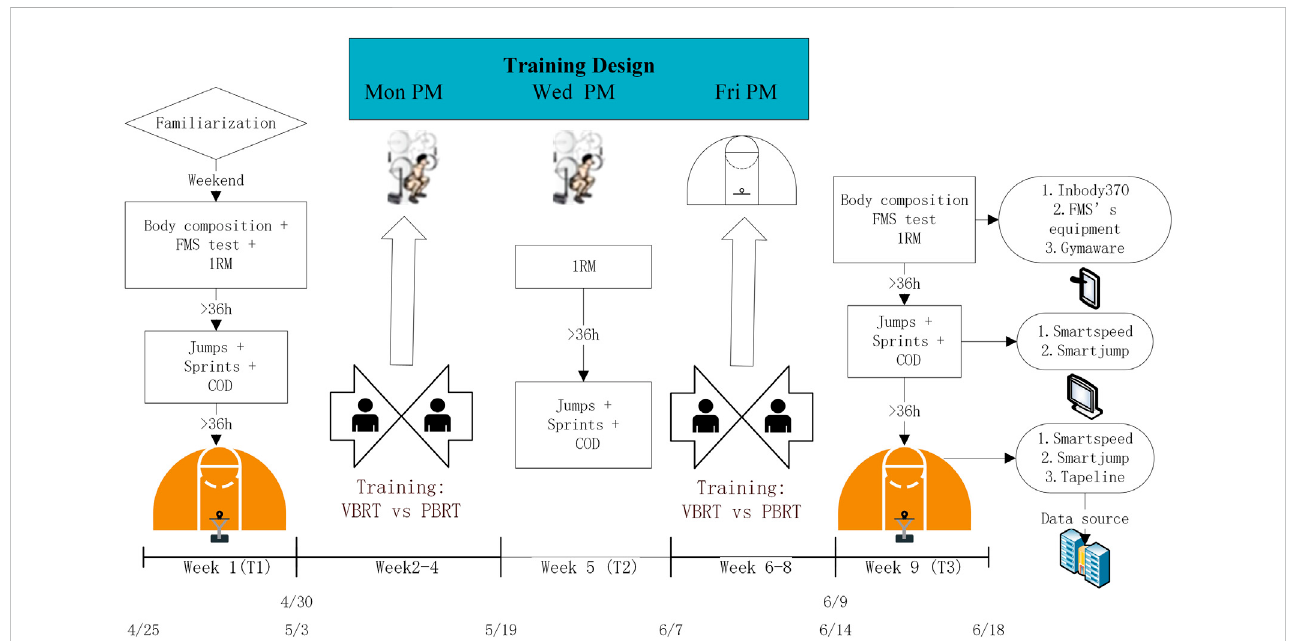
FIGURE 2 Overall experimental study design and weekly off-season training schedule during the 6-week resistance